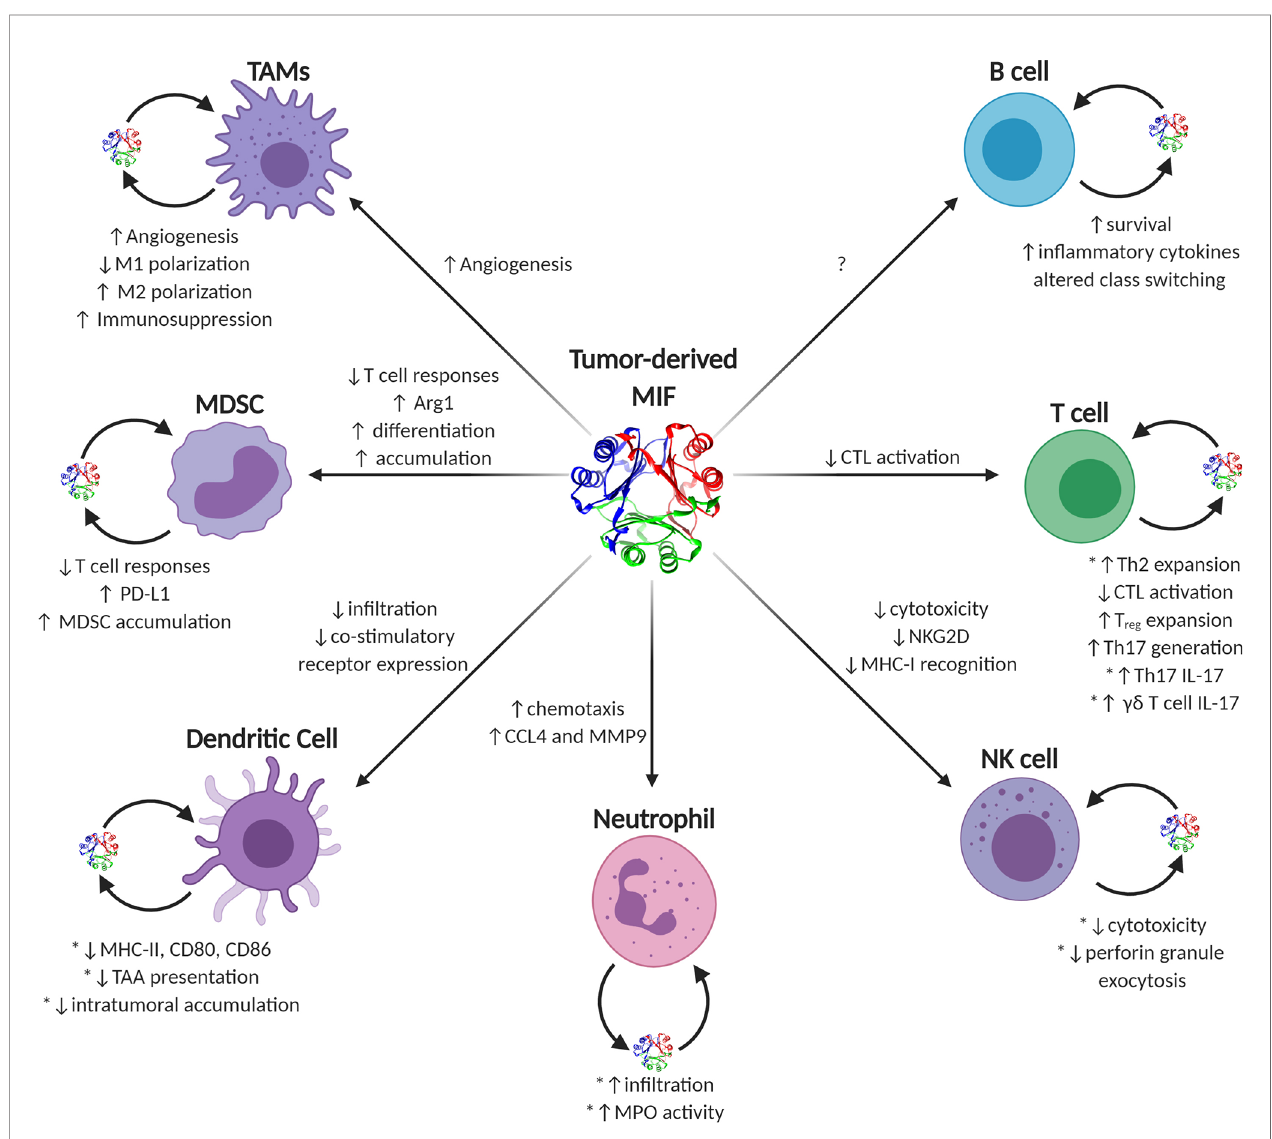
FIGURE 2 | Known and putative effects of MIF on tumor-in fi ltrating immune cells. Graphical depiction of immune effector cells known to be in fl uenced by MIF. Sources of intratumoral MIF include both paracrine acting tumor-secreted and autocrine acting immune cell-secreted MIF. Phenotypes ascribed to tumor-derived MIF on individual cell types are listed next to each corresponding arrow to each cell type, while autocrine-associated activities are noted next to each cell with the caveat that those activities validated using recombinant MIF sources are noted with an